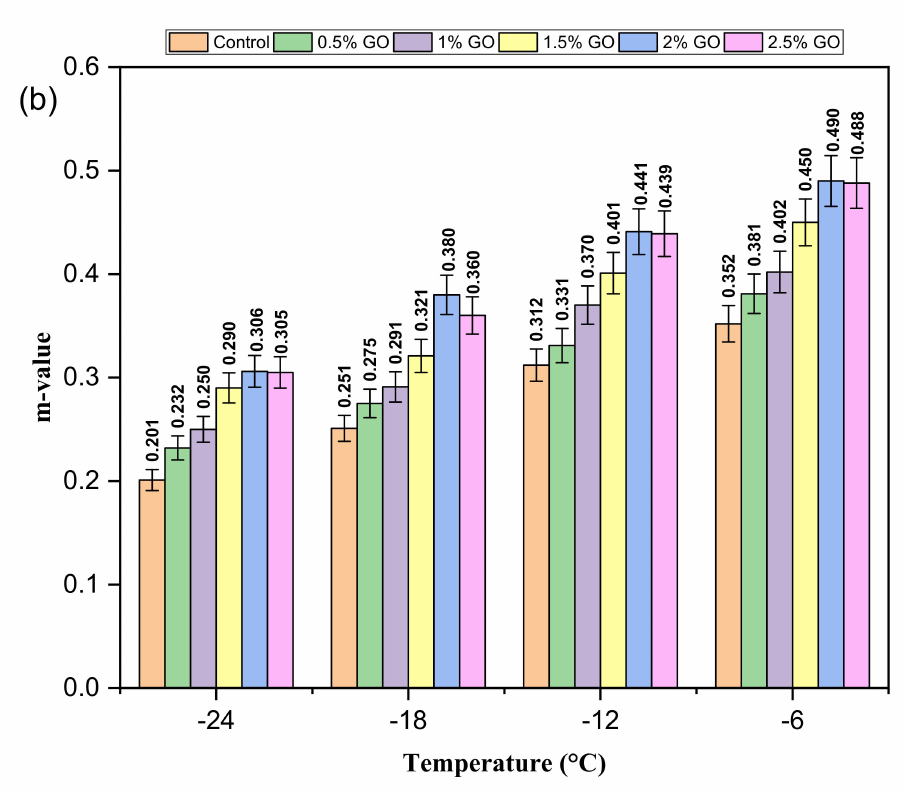
Figure 8. BBR test results: ( a ) creep stiffness (S) and ( b ) creep rate (m-value) of GO-modified binders at different temperatures.